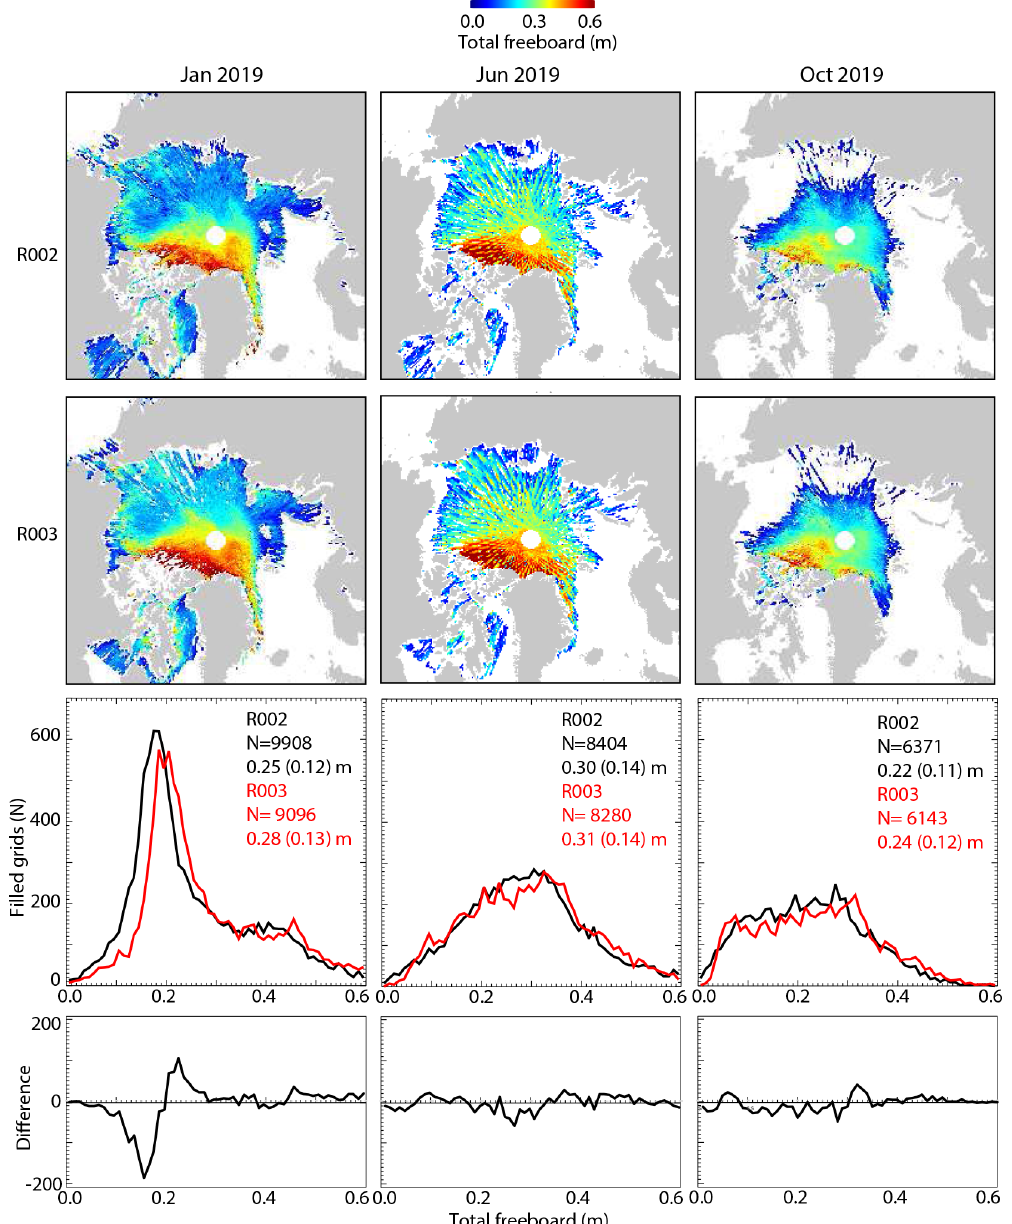
Figure 5. Differences of monthly composite freeboard statistics and coverage between Releases 002 and 003 in the Arctic IS-2 sea ice products for the months of January, June and October 2019. Only specular leads are used in Release 003. N is the number of grid cells (25 by 25km) that are covered, and numerical values show the mean and standard deviation of the composite